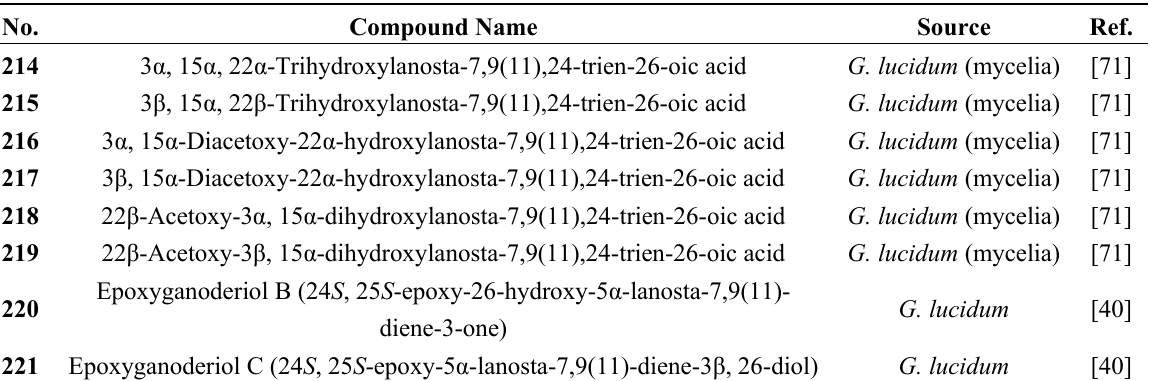
Table 8. Ganoderma triterpenes ( 214 – 221 ) in Figures 21 and 22.